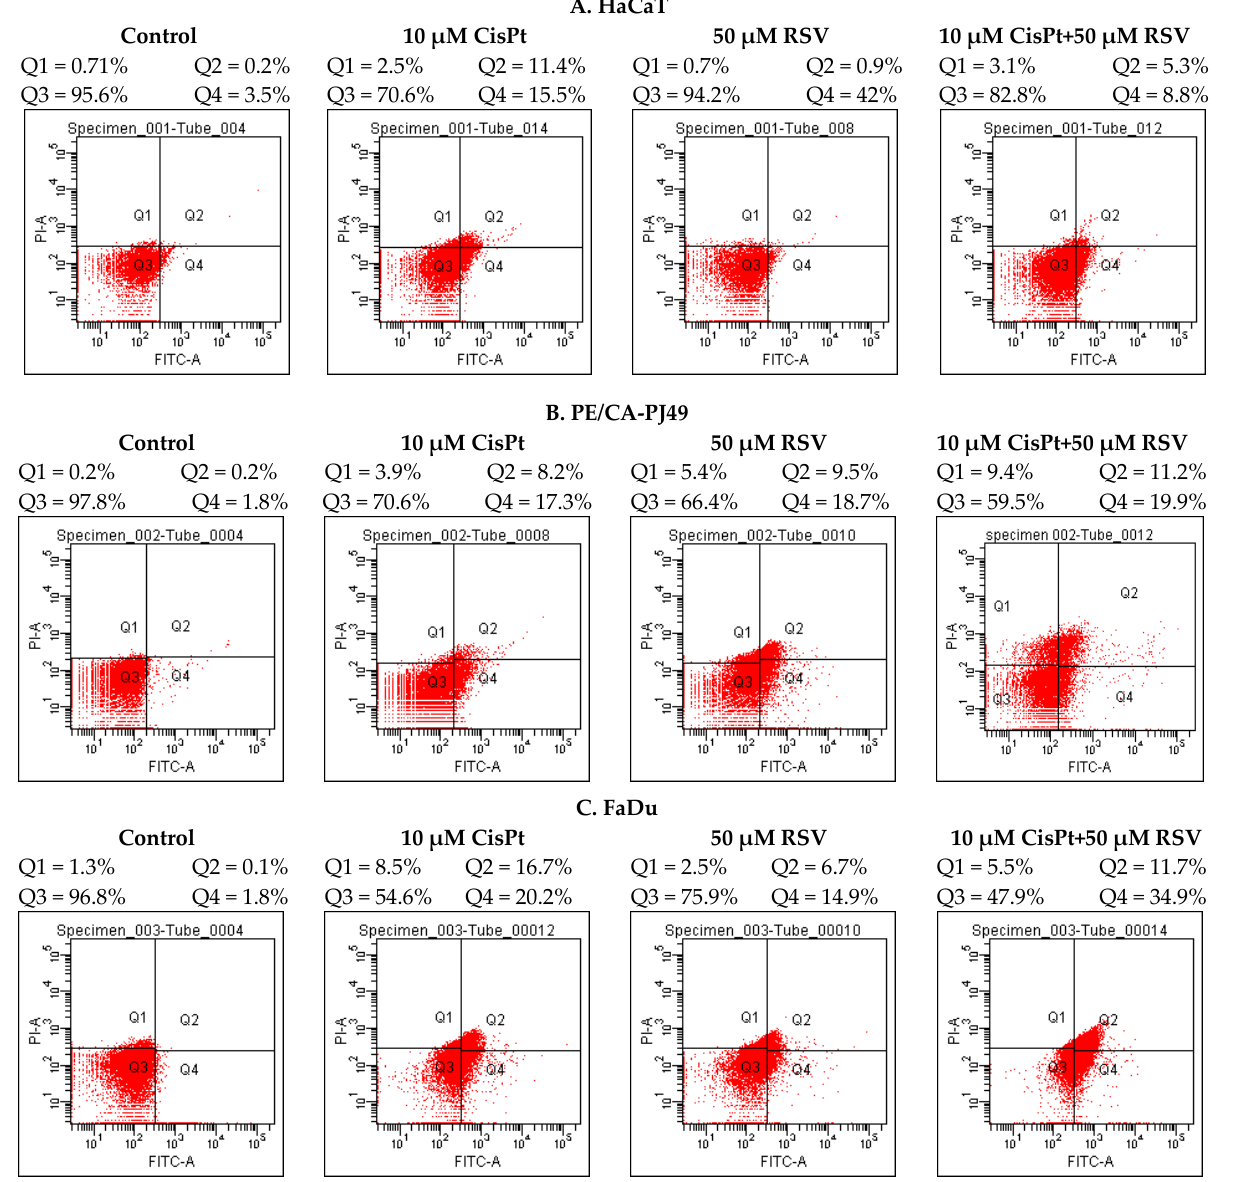
Figure 3. Apoptosis of PE/CA-PJ49 ( B ) and FaDu ( C ) tumor cells versus HaCaT ( A ) normal cells induced by 24 h treatment with RSV and/or CisPt.